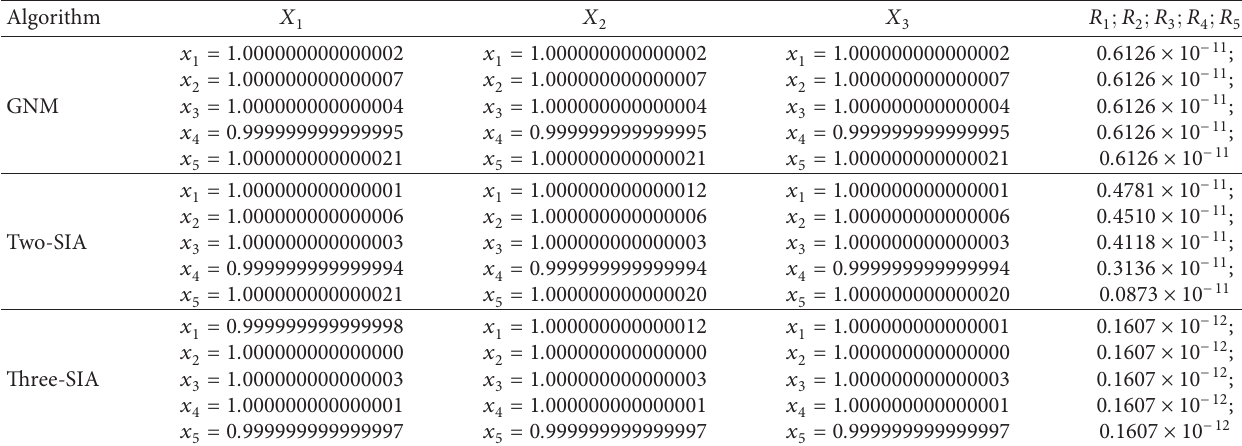
Table 4: The comparison of three-SIA, two-SIA, and GNM for Example 4.